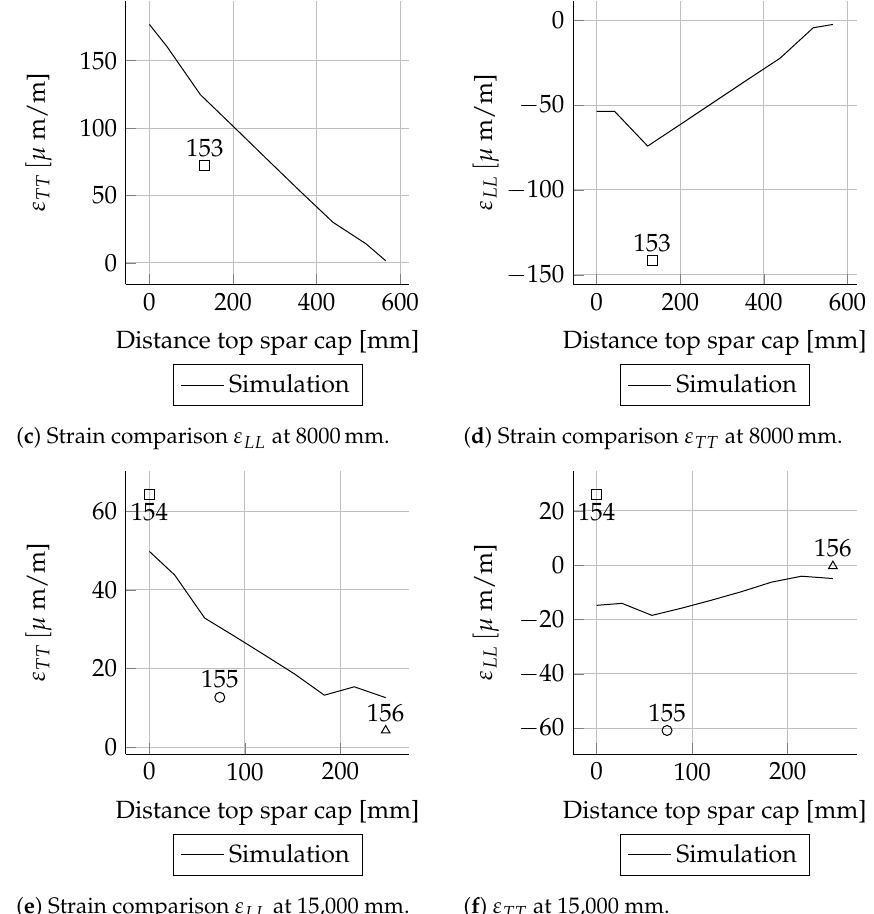
Figure A26. Spar normal strains for MxMin load case.